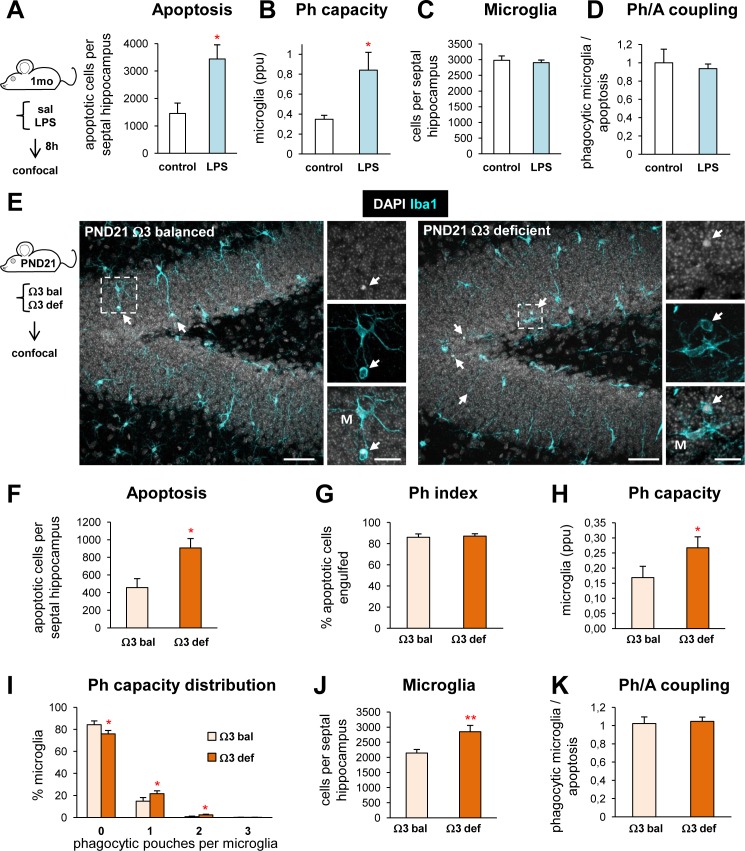
Microglial phagocytic response during in vivo acute and chronic inflammatory challenge.(A) Experimental design and apoptosis in the DG of c57BL/6 fms-EGFP 1-mo mice injected systemically with LPS (1mg/kg; n = 5) or vehicle (saline; n = 4) 8 h prior to sacrifice. Apoptotic cells were identified by pyknosis/karryorhexis. Fig 2A was generated from data that was originally published as part of [9]. (B) Weighted Ph capacity of microglia (in parts per unit, ppu) in control and LPS mice. (C) Number of microglial cells in control and LPS mice. (D) Ph/A coupling in the 1-mo mouse hippocampus (in fold change) during acute inflammatory challenge. (E) Experimental design and representative confocal z-stacks of the DG of PND21 Swiss mice fed during gestation and lactation with a diet balanced (Ω3 bal; n = 7) or deficient (Ω3 def; n = 7) in the omega 3 polyunsaturated fatty acid, a diet that induces chronic inflammation in the hippocampus. Microglia were labeled with Iba1 (cyan) and apoptotic nuclei were detected by pyknosis/karyorrhexis (white, DAPI). Arrows point to apoptotic cells engulfed by microglia (M). Scale bars = 50 μm; z = 22.5μm. (F) Number of apoptotic (pyknotic/karyorrhectic) cells in mice fed with Ω3 balanced and deficient diets. (G) Ph index in the PND21 hippocampus (in % of apoptotic cells) in mice fed with Ω3 balanced and deficient diets. (H) Weighted Ph capacity of microglia (in ppu) in PND21 mice. (I) Histogram showing the Ph capacity distribution of microglia (in % of cells) in PND21 mice. (J) Total number of microglial cells (Iba1+) in PND21 mice. (K) Ph/A coupling in PND21 mice. Bars represent mean ± SEM. * indicates p < 0.05 and ** indicates p < 0.01 by one-tail Student´s t test. Underlying data is shown in S1 Data.